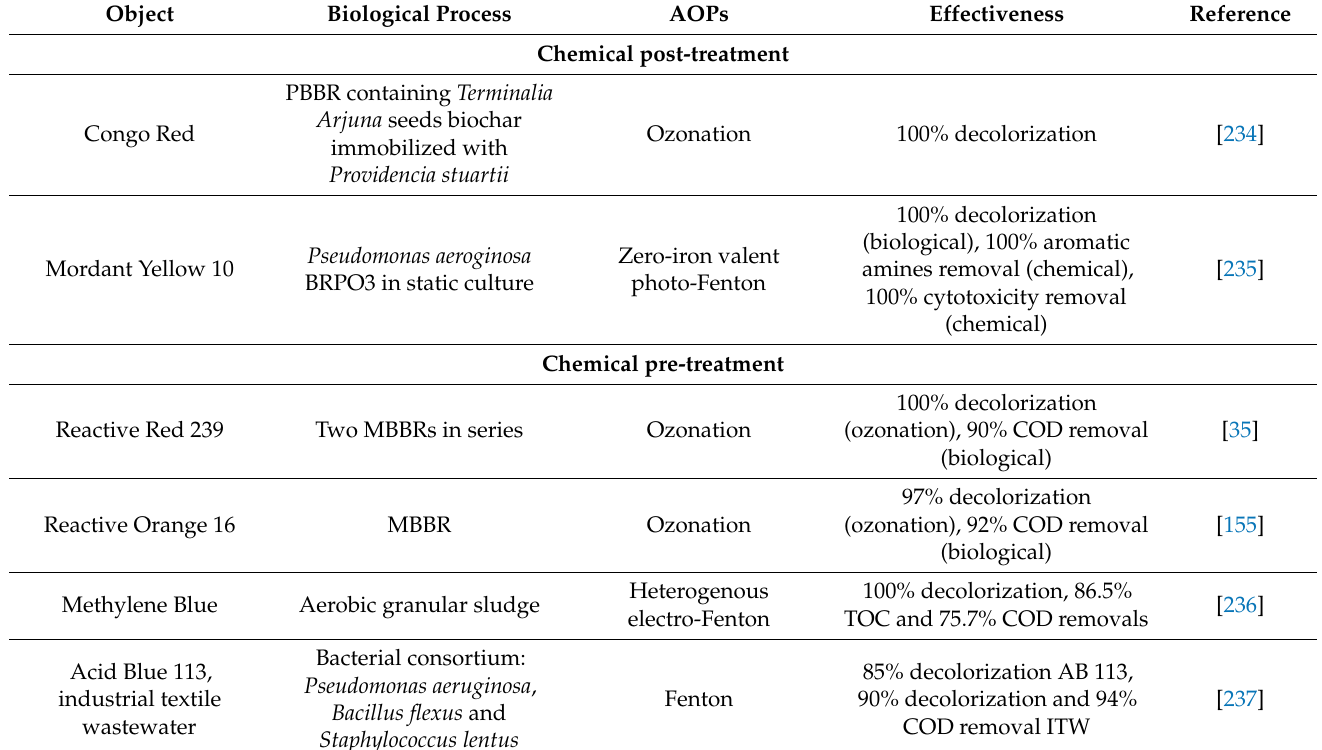
Table 5. Brief summary of dyes removal using combined processes (last three